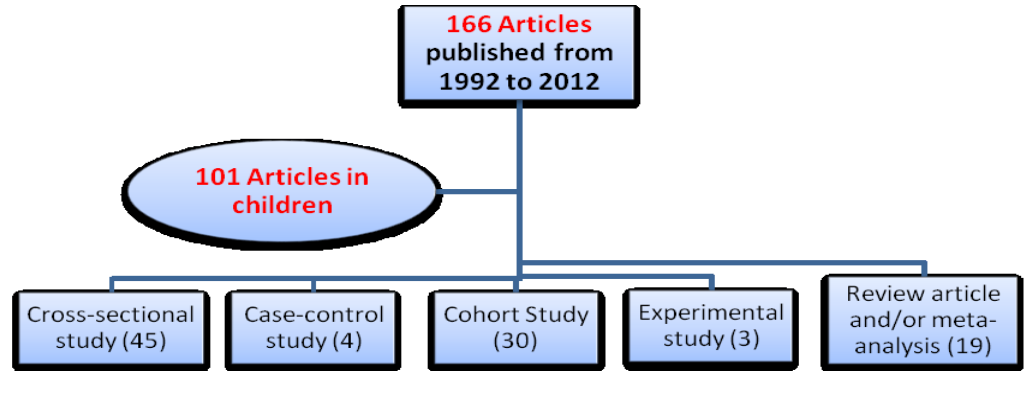
Figure 2. Number and study design of the selected articles